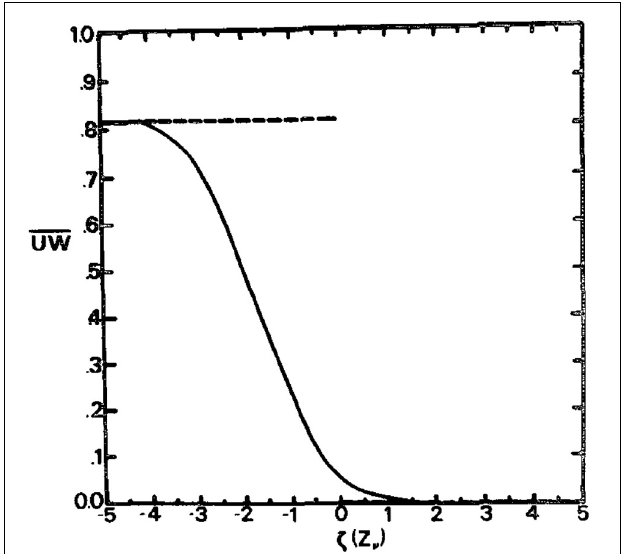
FIGURE 5 | Profile of the momentum flux in a region containing a total critical level (at ζ = 0, where ζ = ( k | α | /ν ) 1 / 3 z is height scaled by the viscous length scale, with ν being viscosity) for high Ri c . Solid line: Viscous theory, dashed line: inviscid theory. Reproduced from Figure 4 of Fritts and Geller [72]. © American Meteorological Society. Used with